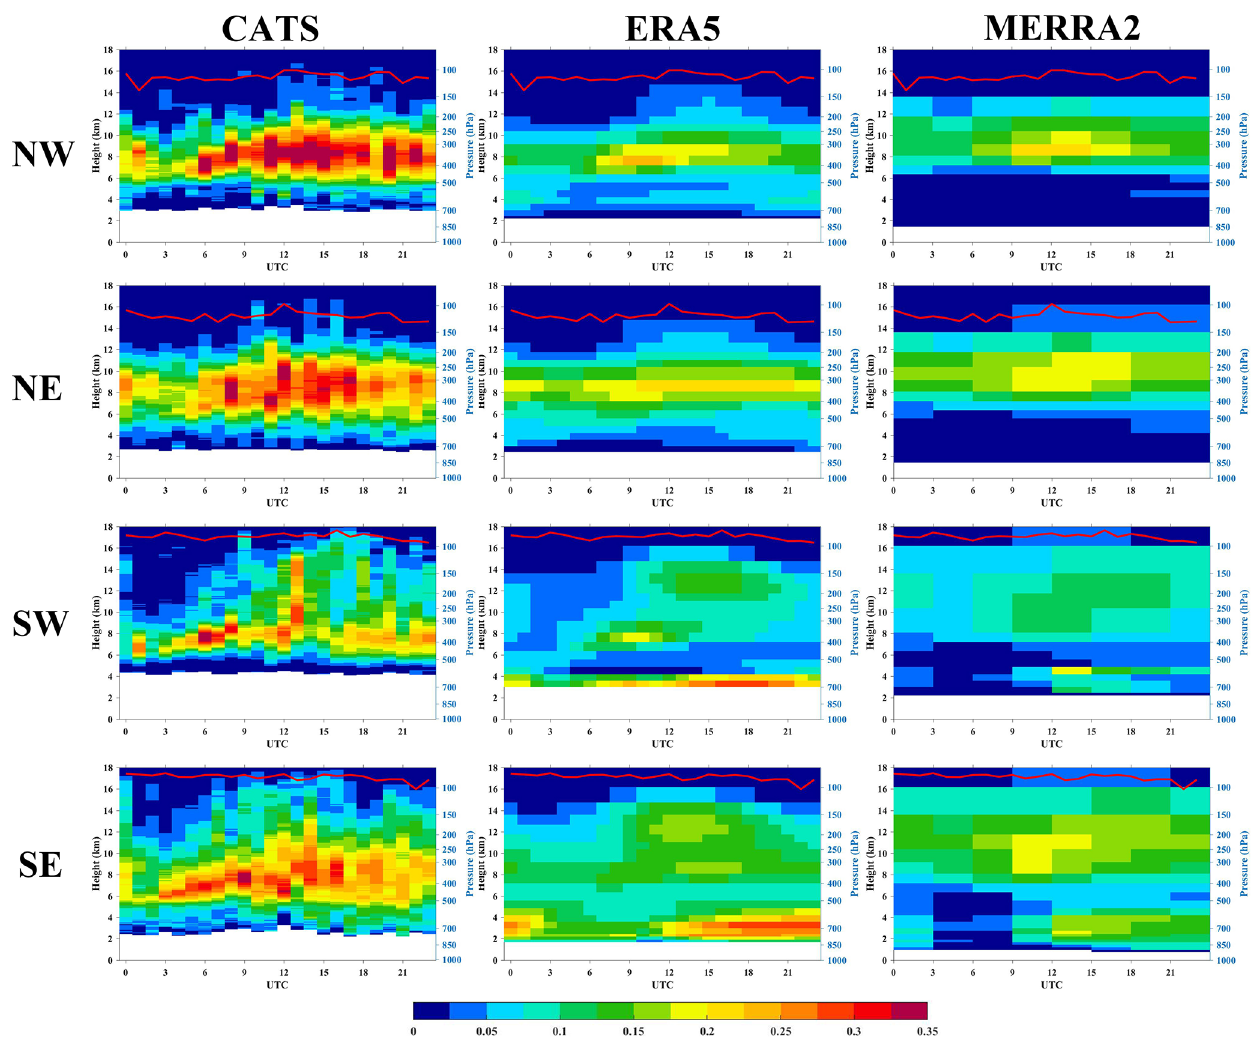
Figure 5. The hourly vertical distribution of cloud cover over different regions of the TP based on CATS, ERA5, MERRA-2. The red lines represent the tropopause height. The first to fourth lines represent the results over the northwestern TP, the northeastern TP, the southwestern TP and the southeastern TP, respectively. The regions are divided by latitude and longitude lines of 33 ◦ N and 89 ◦ E (shown in Fig. 1). The grids with total sample number less than 50 are